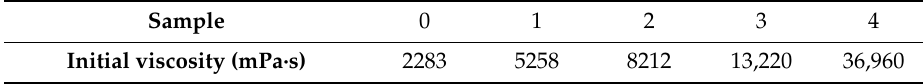
Table 3. The apparent viscosity of di ff erent adhesives: 0: WF adhesive, 1: WF / HMP-10 adhesive, 2: